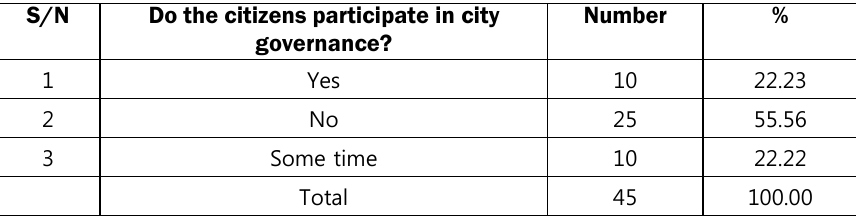
TABLE 10: Officials’ views about the participation of citizens in city governance S/N Do the citizens participate in city